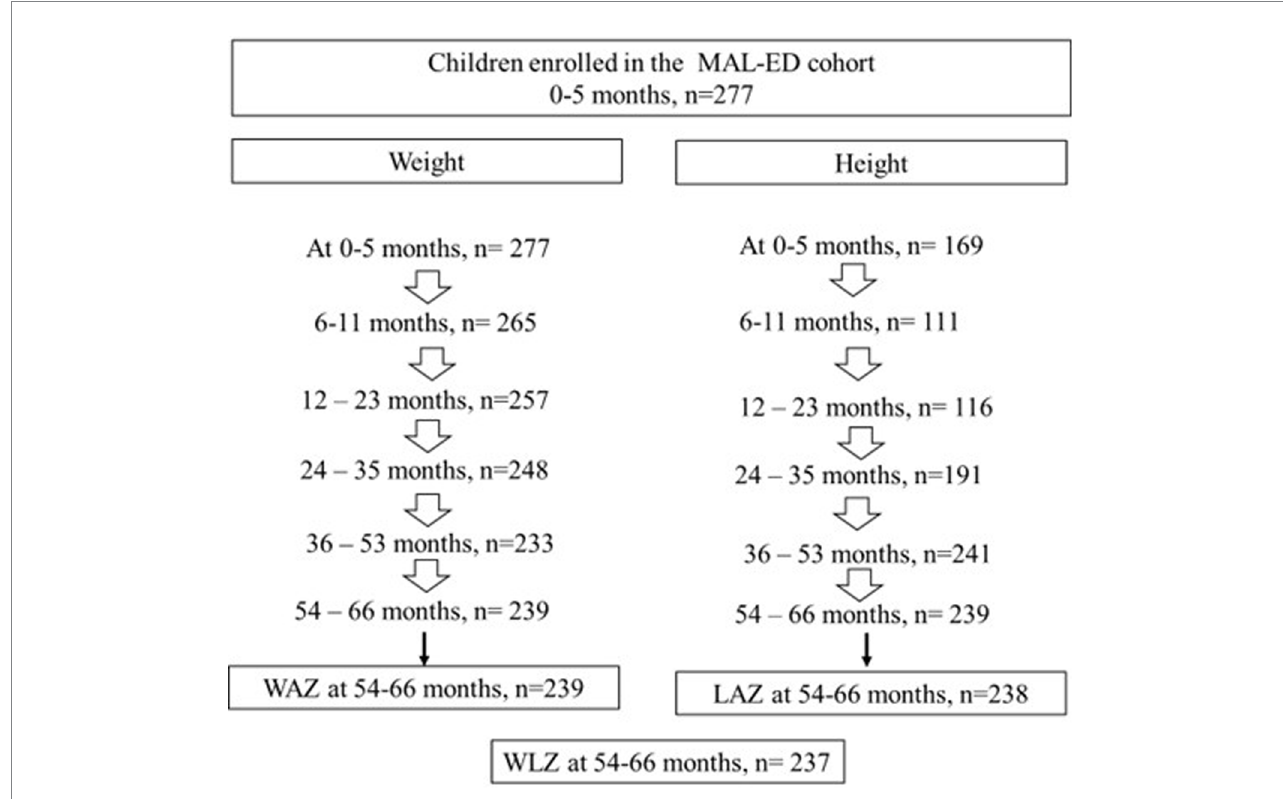
FIGURE 1 Sample size flow chart of children enrolled and followed between 0 and 5 years of age in the MAL-ED cohort in